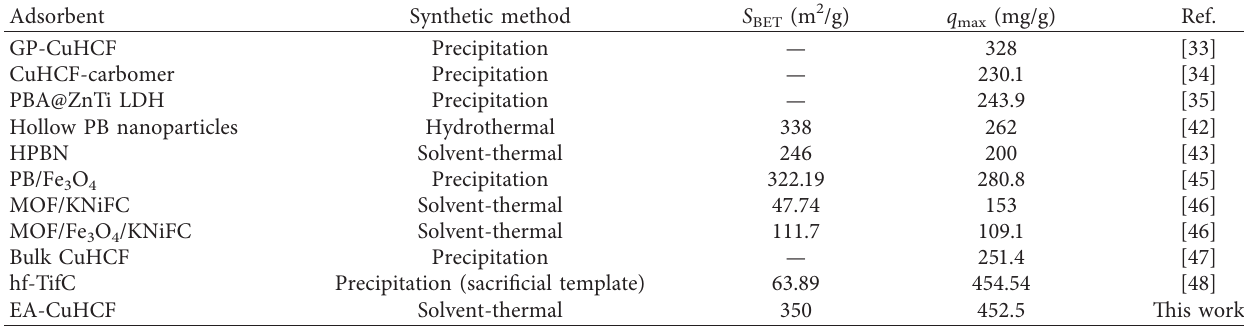
Table 2: Summary of the adsorption capacity of various Prussian blue adsorbents.